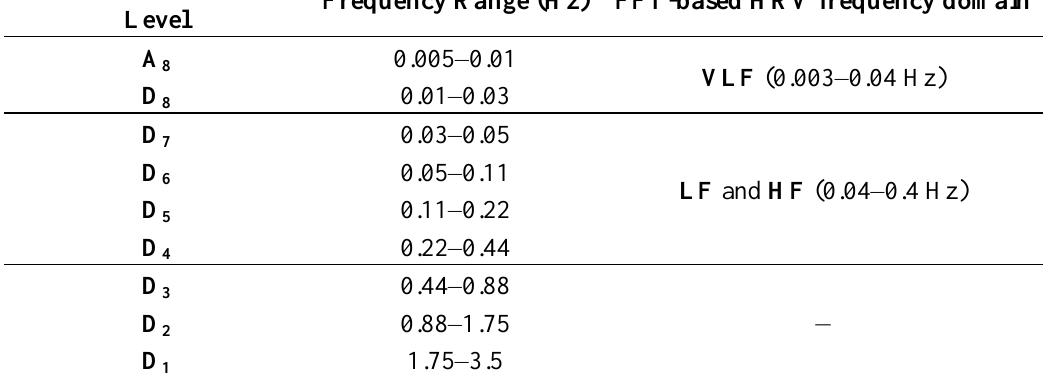
Table 4. Comparison of the frequency ranges of the decomposition at each level and the conventional FFT-based HRV frequency